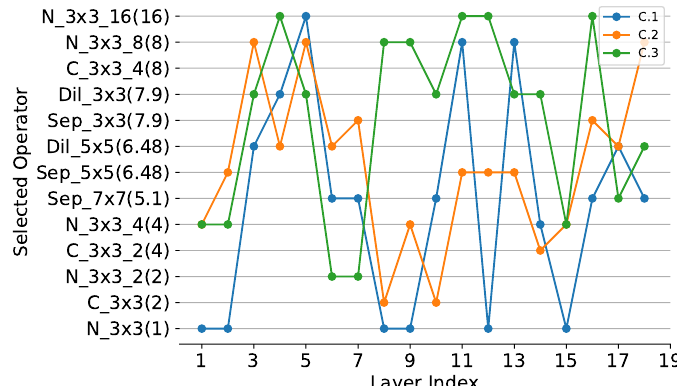
Figure 5. The operator of each layer in compressed ResNet20. The layers in the figure do not include the first convolutional layer and the last fully connected layer. From bottom to top on the vertical axis, the operators are increasingly lightweight. The float number in ( · ) represents the lightness of operator, the higher the value is, the lighter the operator is. The model located in the upper part of the figure is more lightweight.